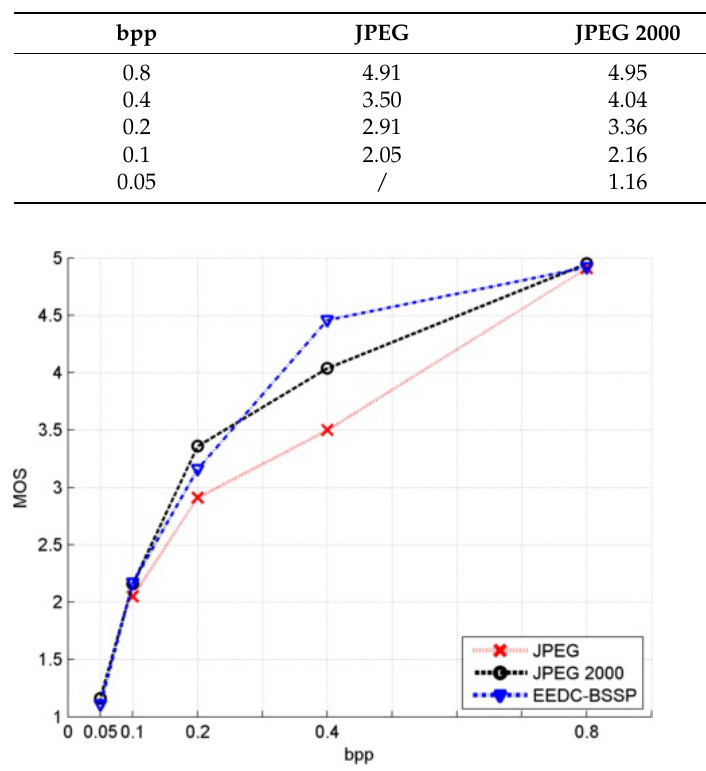
Table 25. MOS values for image mask at various compression ratios.